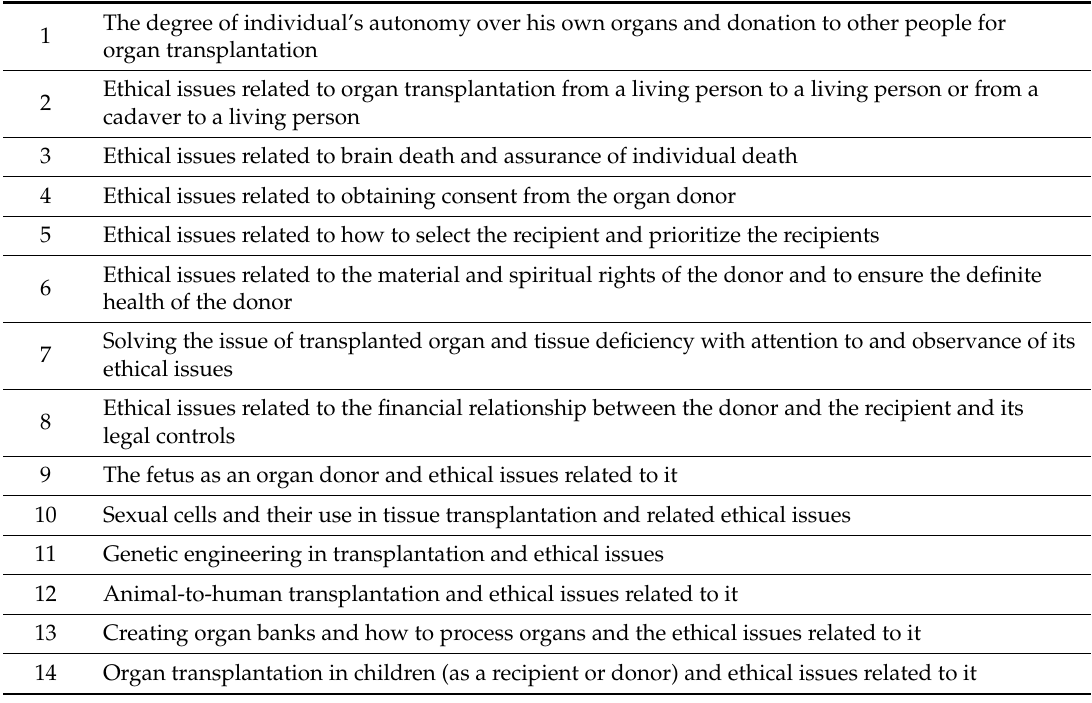
Table 3. Different dimensions of the ethical issues in organ